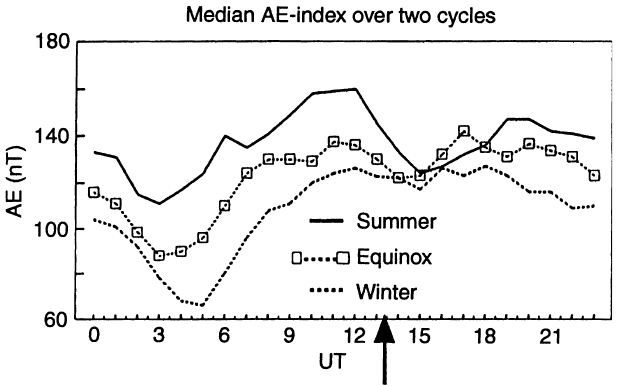
Fig. 6. Overall trends in the median values of AE-index for the two solar cycles and for di(cid:128)erent